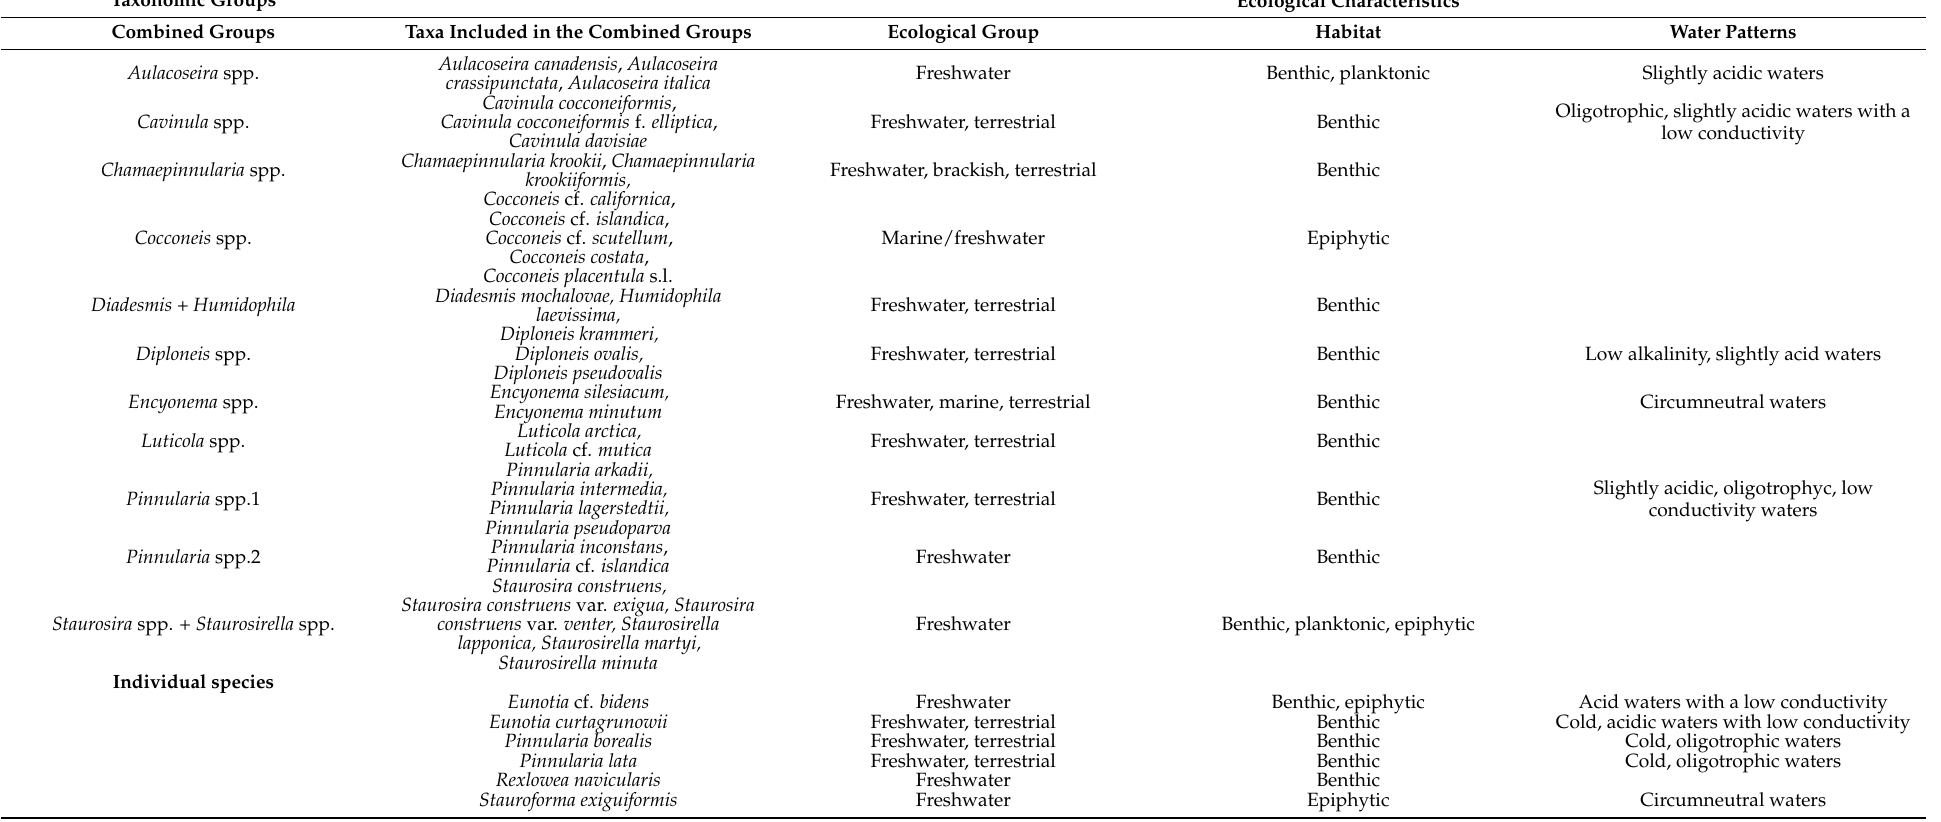
Table 1. Species and taxonomic groups of diatoms and their ecological preferences (according to [51,54,55,59–61]) included in the